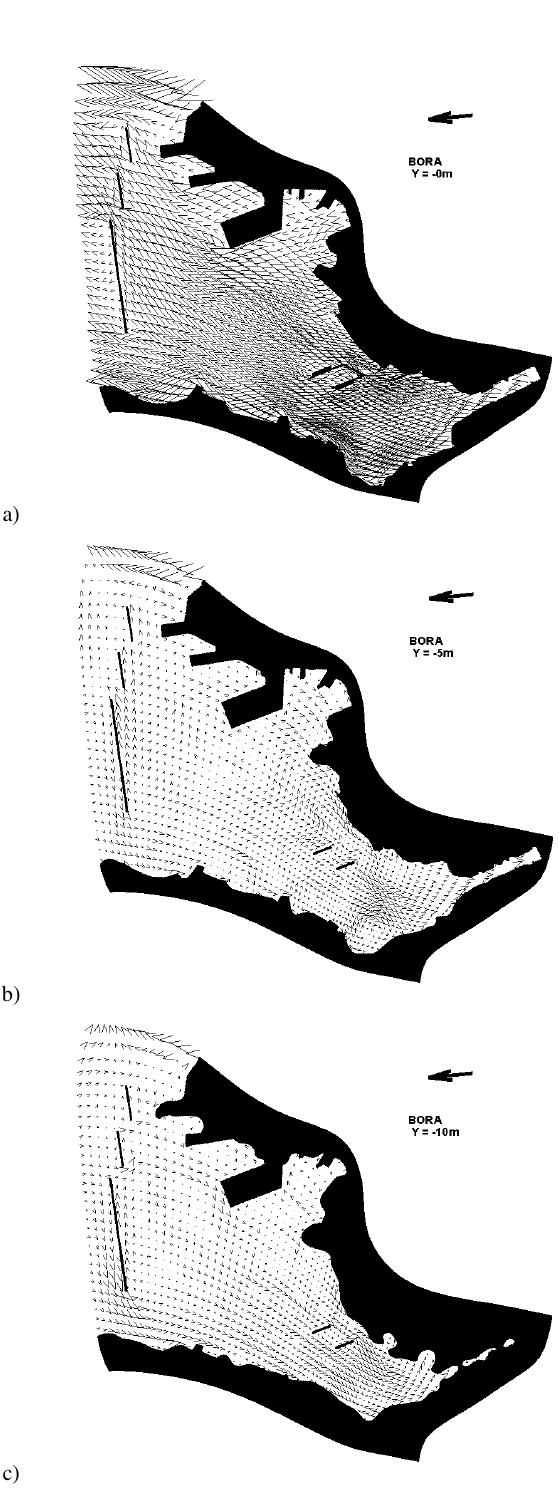
Fig. 17. Horizontal velocity vector field for Bora wind simulation averaged over a period of three hours; for clarity purposes, only one vector is shown every 15 points in x and z . (a) Sea surface; (b) 5m below the sea surface; (c) 10m below the free surface.